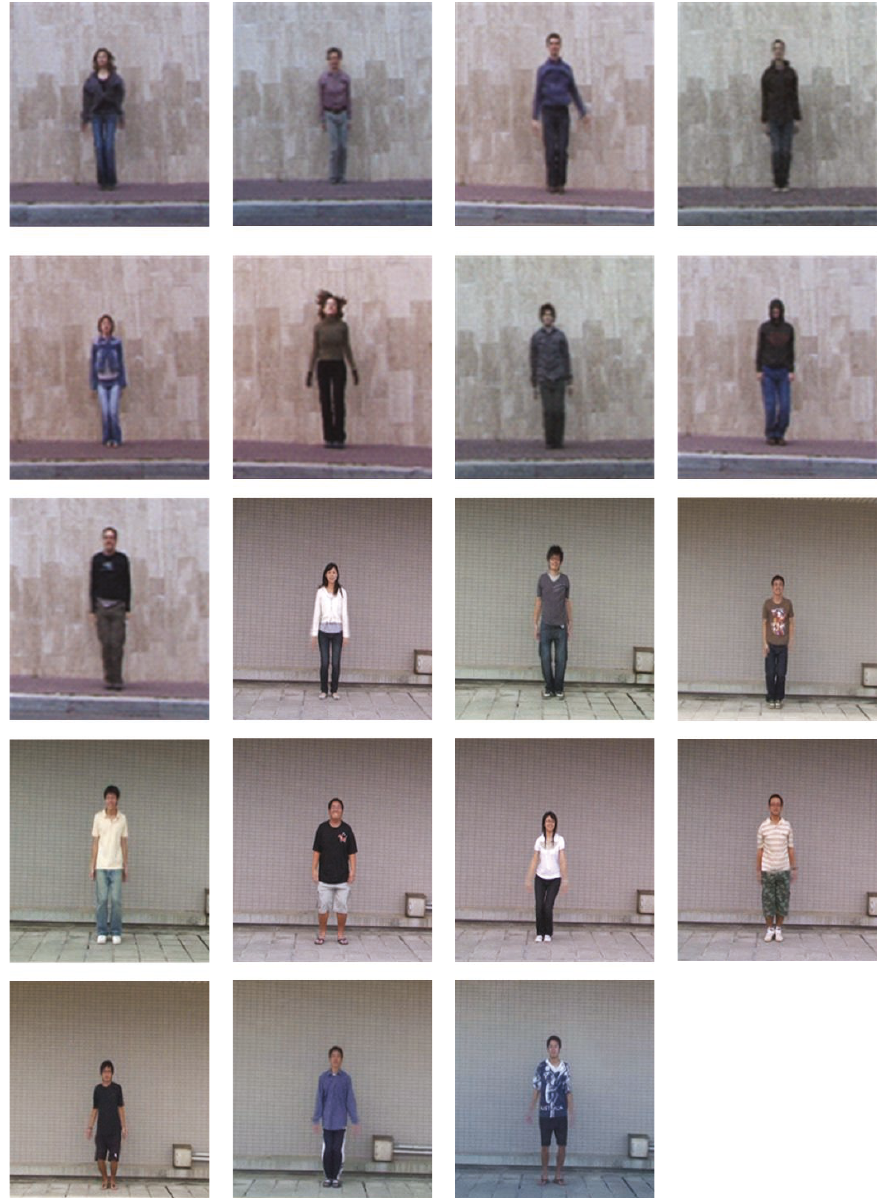
Figure 8: Subjects used in the action recognition